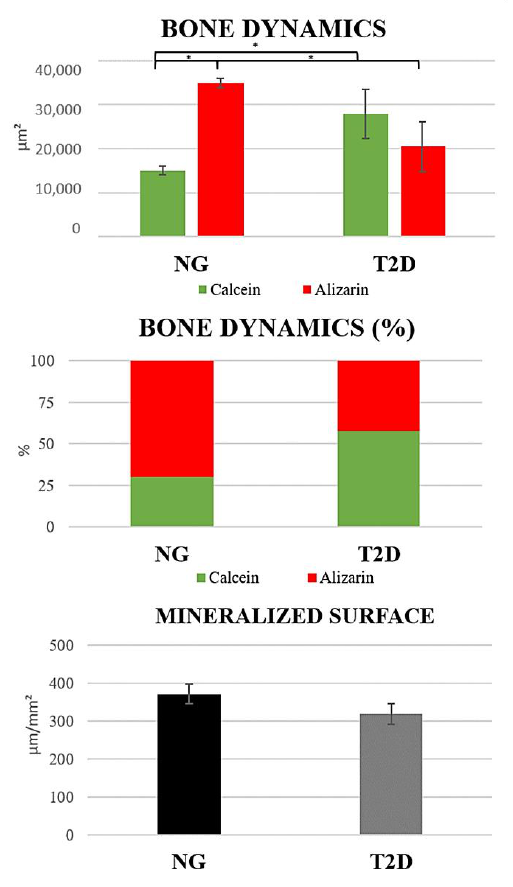
Figure 8. Confocal microscopy results. Bone Dynamics: The graphs show a statistically significant difference between the fluorochrome precipitations, where T2D presents a lower percentage of new bone and a higher percentage of old bone. Mineralized surface: There is no statistically significant difference between the mineralized surface area. Symbols: Error bar; * p < 0.05. Mineralized Surface: There was no statistically significant di ff erence between the groups ( p = 0.5849), where T2D shows smaller mineralized area (MS = 318.4 µ 2 ) when compared to NG (MS = 371.4 µ 2 ) (Figure